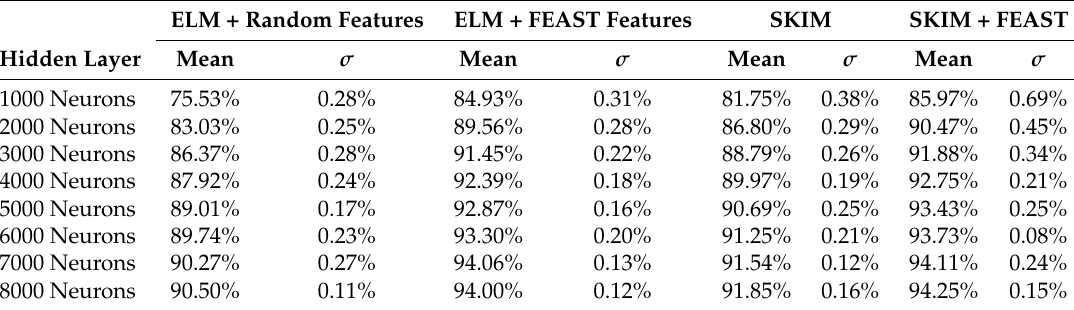
Table 1. Classification accuracy for the ELM network on raw events and on FEAST events and the SKIM network using random and FEAST features. The classification accuracy is reported in terms of percentage of digits correctly identified using 200 11 × 11 pixel features. Ten trials of each configuration were